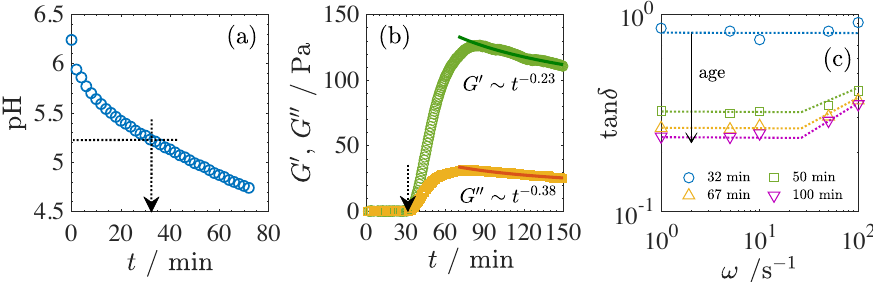
Figure 1. Time evolution of pH value ( a ), time evolution of the storage and loss moduli measured at ω = 1 s − 1 ( b ), and tan δ as a function of ω (c). Vertical arrows in panels ( a , b ) indicate the time when pH value reached pH = 5.2, a measure of the initiation of the gelation. Solid curves in panel ( b ) correspond to power law relations, G (cid:48) ∼ t − 0.23 and G (cid:48)(cid:48) ∼ t − 0.38 . Dotted lines in panel ( c ) are the guide for eyes. Each symbol corresponds to the data measured at different times, t